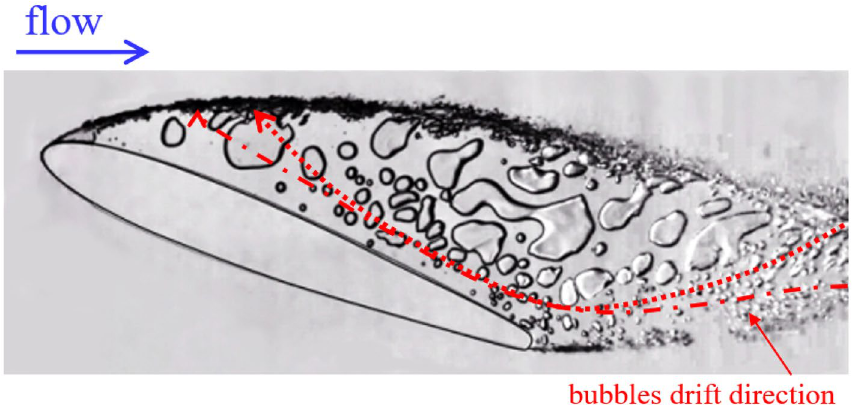
Figure 4. Supercavitating foil. A reverse motion to foil leading edge of the water–vapor mixture phase occurred within the cavity. Re = 1·10 6 . σ =